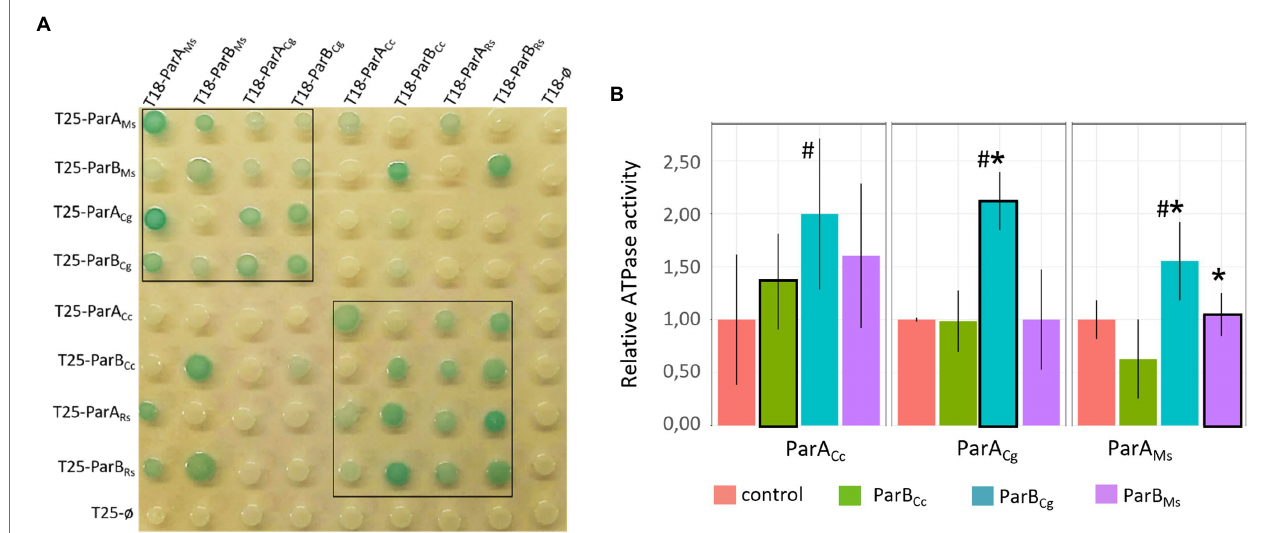
FIGURE 2 | Intergenus interactions between ParA and ParB proteins. (A) Bacterial two-hybrid (BTH) assays testing heterodimerisation (ParA-ParA or ParB-ParB interactions) and interactions between ParA and ParB proteins from M. smegmatis (ParA Ms, ParB Ms ), C. glutamicum (ParA Cg, ParB Cg ), C. crescentus (ParA Cc, ParB Cc ), and ParA1 and ParB1 from R. sphaeroides (ParA Rs, ParB Rs ) fused to either the T18 or T25 subdomain of adenylate cyclase (as indicated) expressed from pKT25 or pUT18C plasmids. Empty pKT25 and pUT18C vectors (T25Ø or T18Ø) served as negative controls. The blue colour of the colonies indicates interactions. The black box frames the colonies co-producing proteins from the same phyla. (B) ATPase assay measuring the influence of different ParB proteins [ M. smegmatis (ParB Ms ), C. glutamicum (ParB Cg ), and C. crescentus (ParB Cc )] on the ATPase activity of ParAs from M. smegmatis (ParA Ms ), C. glutamicum (ParA Cg ), and C. crescentus (ParA Cc ). ParBs showed no ATPase activity and ATPase activities of ParA proteins in absence of ParB (shown in Supplementary Figure S1A ) were normalised to 1. The plot shows the average from three replicates with SE. Stimulation of the ATPase activity of ParA by cognate ParB is marked with black frames. Statistically significant differences are marked with # ( p < 0.15, test T-Student). Asterisks indicate ParA-ParB interactions confirmed by BTH (A)